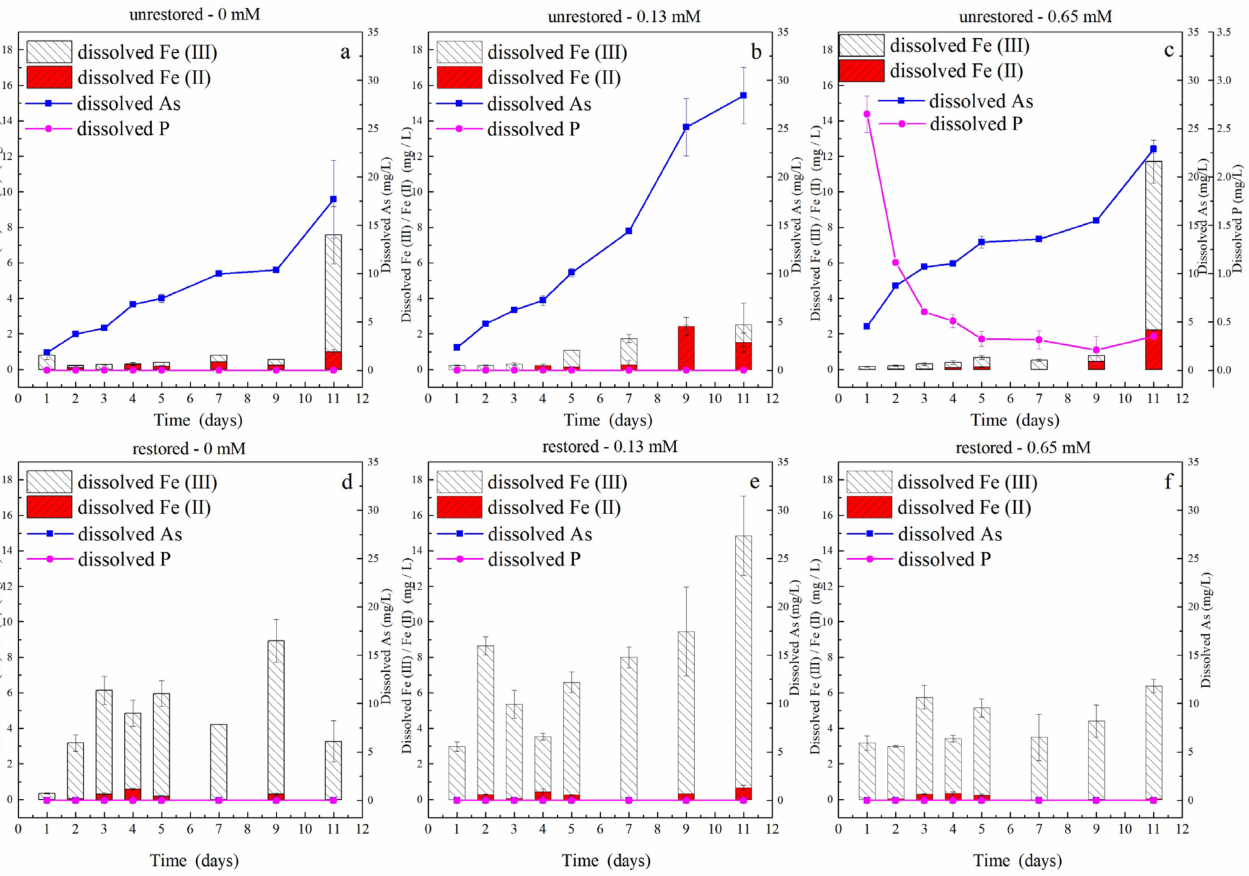
Figure 7. Variation in dissolved As, Fe(II), and Fe(III) concentrations in the supernatant under biotic conditions with different phosphate concentrations in unrestored and restored soils. ( a ) Unrestored, 0 mM, ( b ) unrestored, 0.13 mM, ( c ) unrestored, 0.65 mM, ( d ) restored, 0 mM, ( e ) restored, 0.13 mM, ( f ) restored, 0.65